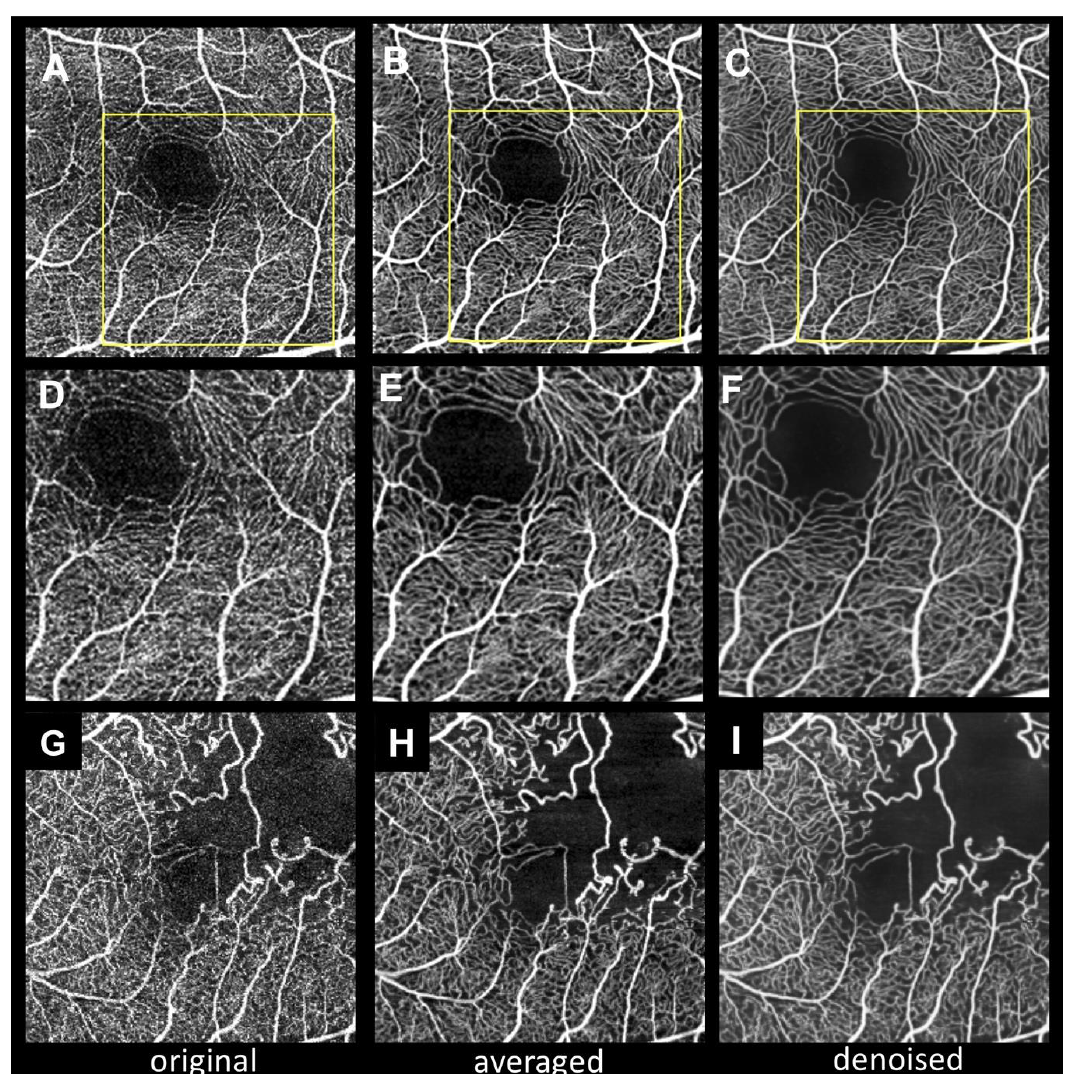
Figure 1. Impact of deep learning denoising on the quality of optical coherence tomography angiography (OCTA) images. ( A–C ), OCTA images of normal superficial capillary plexus obtained using a 3 × 3 mm 2 scan pattern. ( D–F ), Magnified images of open squares in A–C. ( G–I ), OCTA images of branch retinal vein occlusion. A, D, G, Original OCTA images. B, E, H, Averaged OCTA images. C, F, I, Denoised OCTA images. Averaging and deep learning denoising provide background noise reduction and annealing of disconnected vessels, resulting in noiseless, smooth, and high-contrast images. The contrast-to-noise ratios (CNRs) of A, B, C, G, H, and I are 1.03, 1.42, 1.74, 0.77, 1.16, and 1.27,